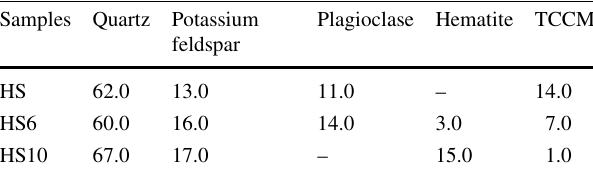
Table 4 Minerals in raw stone coal and ash samples (%) Samples Quartz Potassium feldspar